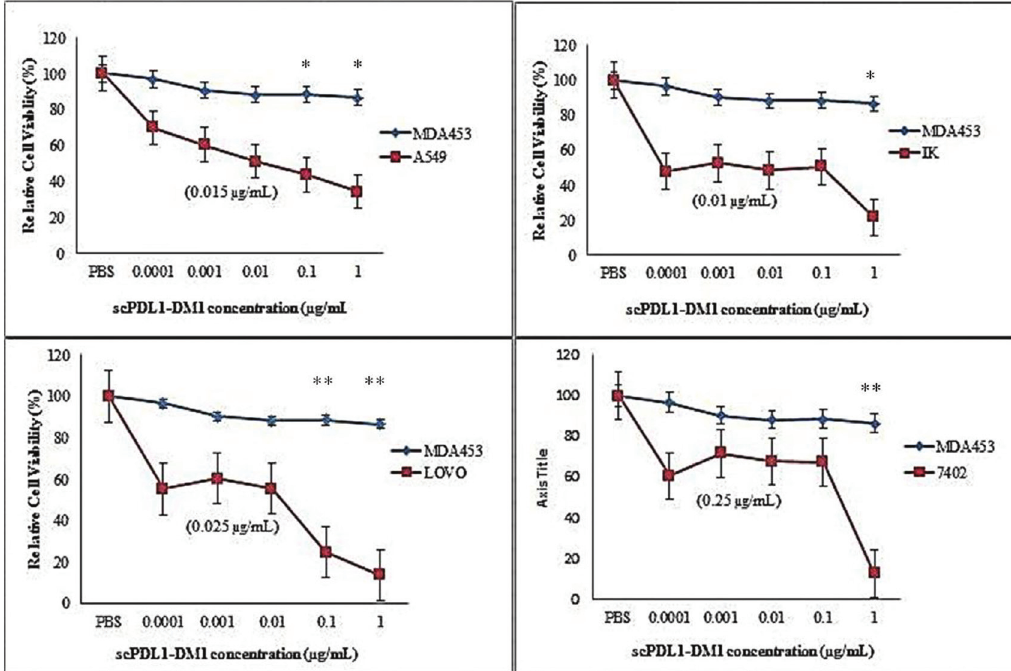
Figure 5 - Cell viability detection after 60 hours by MTT analysis. ScPDL1-DM1 conjugate induces cell lysis and apoptosis effect on A549, IK, LOVO, and7402tumorcelllinesbuthasnoeffectonPD-L1negativeMDA453cells.MDA453cellswereusedascontrol.Thesecellswereincubatedin96wells plate in drug conjugate for 60 hours. PBS was also used as a negative control. The IC50 values for each cell line are shown in parentheses. The test experi- ments were repeated three times as indicated in standard bars. One-way ANOVA was used to analyze the cell viability after 48 hours of cell treatment, **p<0.01,